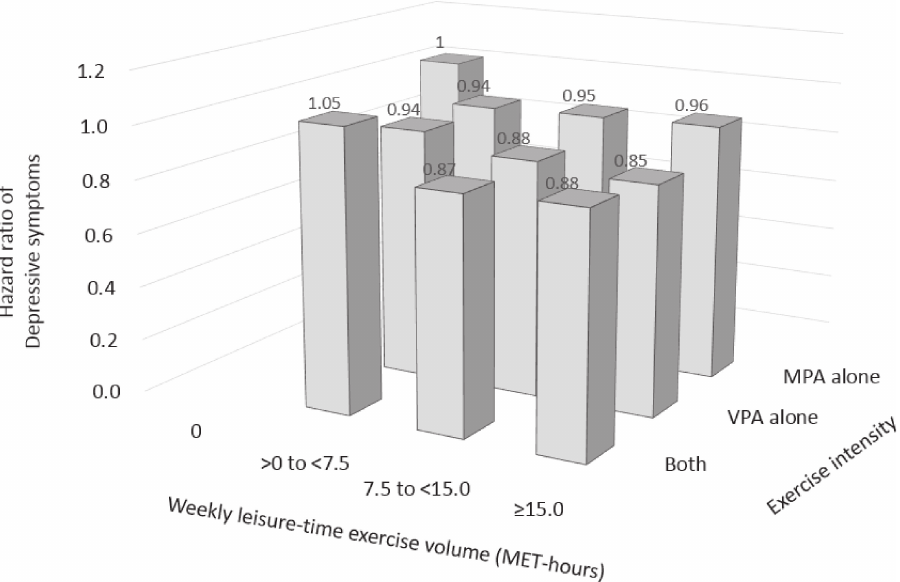
Figure 1. Hazard ratio of developing depressive symptoms according to the volume and intensity of leisure-time exercise. Data were adjusted for age (continuous, year), sex, smoking (non-smokers, smokers consuming 1 to 10, 11 to 20, or ; 21 cigarettes per day), alcohol consumption (non-drinkers, drinkers consuming < 1, 1 to < 2, or ; 2 go of Japanese sake equivalent per day), sleep duration ( < 5, 5 to < 6, 6 to < 7, or ; 7 hours per day), walking to and from work ( < 20, 20 to < 40, or ; 40min per day), occupational physical activity (sedentary, mostly standing or walking, or fairly physically active), shift work (yes or no), monthly overtime work ( < 45, 45 to 60, 60 to < 80, 80 to < 100, or ; 100 hours), job position (high or low), marital status (married or not), body mass index ( < 18.5, 18.5 to < 23.0, 23.0 to < 25.0, 25.0 to < 30.0, or ; 30.0kg / m 2 ), and depression score (continuous) at baseline. No exercise was treated as reference. MPA, moderate-intensity physical activity; VPA, vigorous-intensity physical